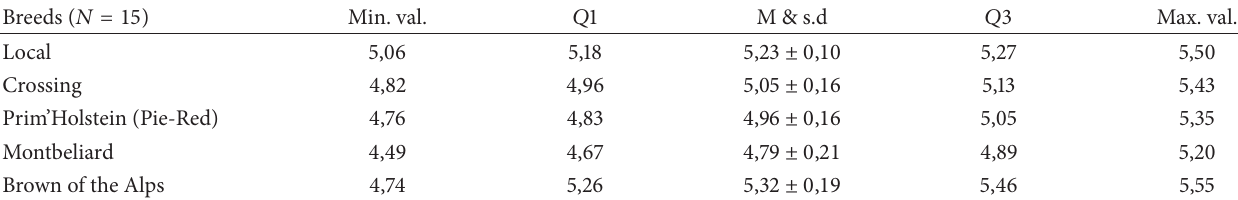
Table 1: Terminal values, averages, standard deviation, and quartiles of the diameter of red blood cells of cattle (expressed in 𝜇 m). Breeds ( 𝑁 = 15 ) Min. val. 𝑄 1 M & s.d 𝑄 3 Max. val. Local 5,06 5,18 5 , 23 ± 0 , 10 5,27 5,50 Crossing 4,82 4,96 5 , 05 ± 0 , 16 5,13 5,43 Prim’Holstein (Pie-Red) 4,76 4,83 4 , 96 ± 0 , 16 5,05 Montbeliard Brown of the Alps